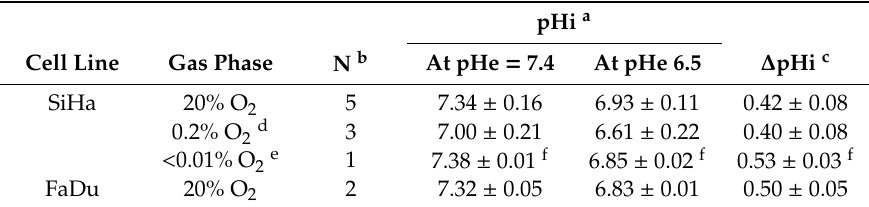
Table 2. Intracellular pH (pHi) of SiHa and FaDu cells at two di ff erent extracellular pH (pHe) values, determined after loading cells with BCECF